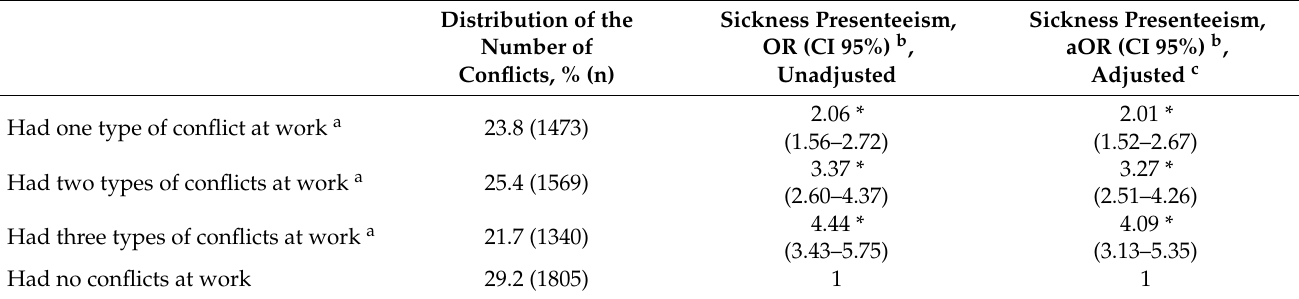
Sickness Presenteeism, aOR (CI 95%) b , Adjusted